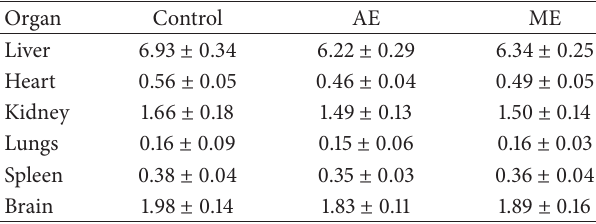
Table 3: Hematological parameters of mice ingested with 2000 mg/kg aqueous (AE) and methanolic (ME) seed extracts of A. esculentus .